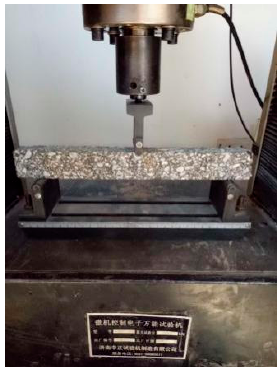
Figure 3. Fatigue test.